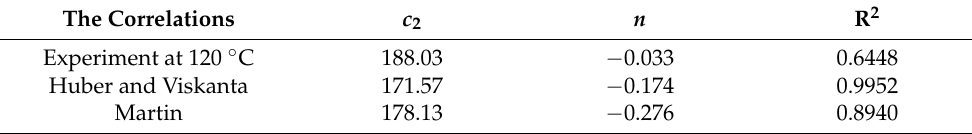
Table 4. The correlations of the Nusselt number as a function of H / d , Nu = c 2 ( H/d ) n . The